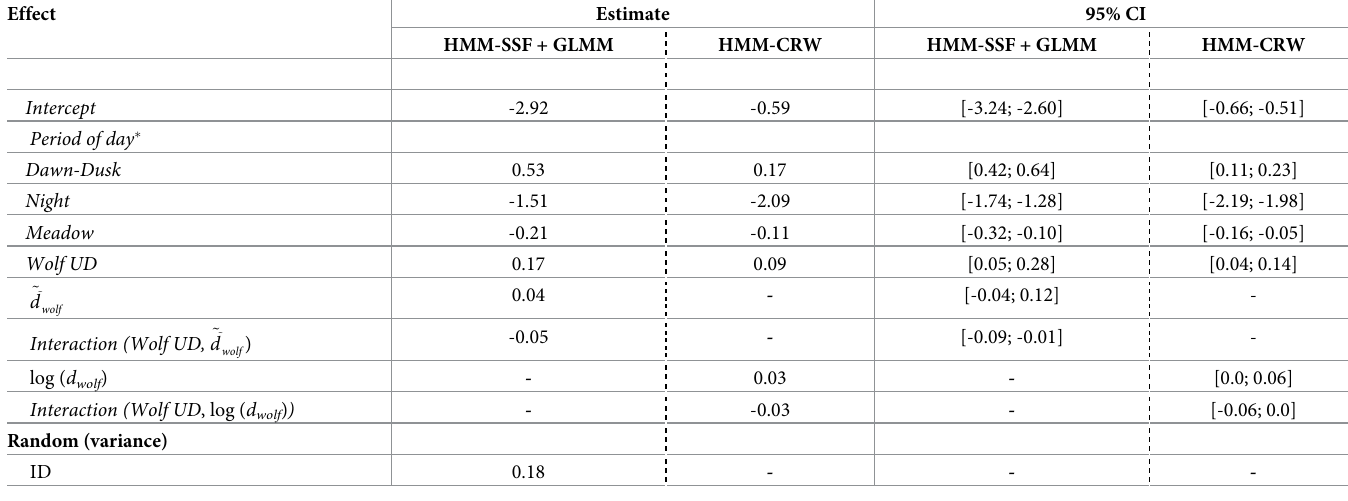
Table 4. Coefficient estimates along with their 95% confidence interval (95% CI) of the mixed-effects generalized linear model with binomial distribution (HMM-SSF + GLMM) and the multi-state correlated random walk model (HMM-CRW) to predict probability that a bison switched from encamped to travelling mode during its travel in summer. In the HMM-SSF + GLMM analysis, we used a probability threshold of 0.50 ( Pthreshold ) to determine transition and non-transition from the conditional probabilities of being in encamped or travelling state, as estimated from the HMM-SSF. Mixed-effects generalized linear model was fitted using 27,101 geolocations from 32 GPS-collared plains bison in Prince Albert National Park (SK, Canada). ~ d ~ when d wolf � d threshold and d threshold , otherwise. log ( d wolf ) is the natural logarithm of d wolf